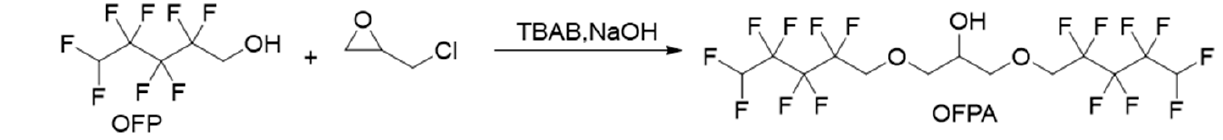
Figure 1. Synthesis route of OFPA.